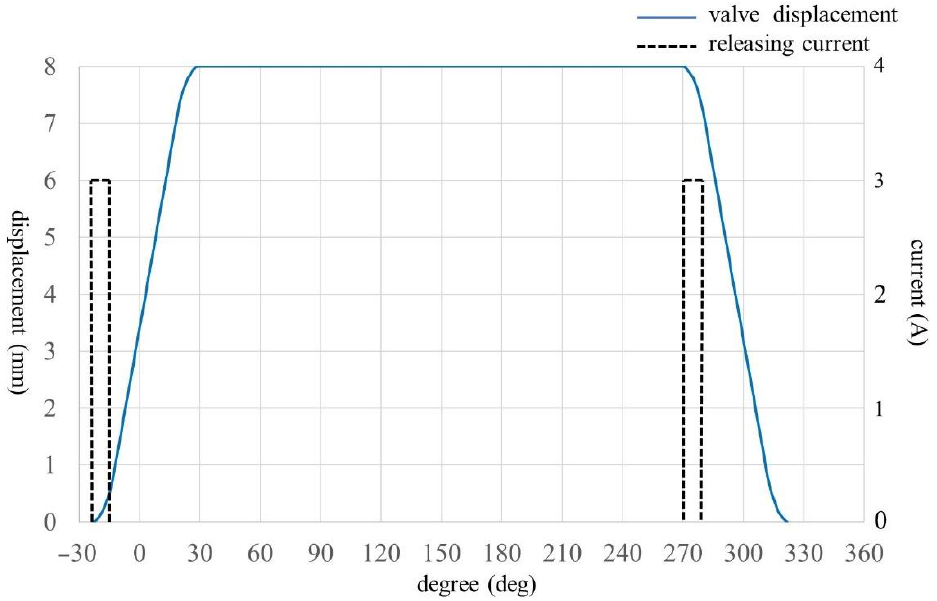
Figure 4. EM valve operation cycle and release current actuation timing.